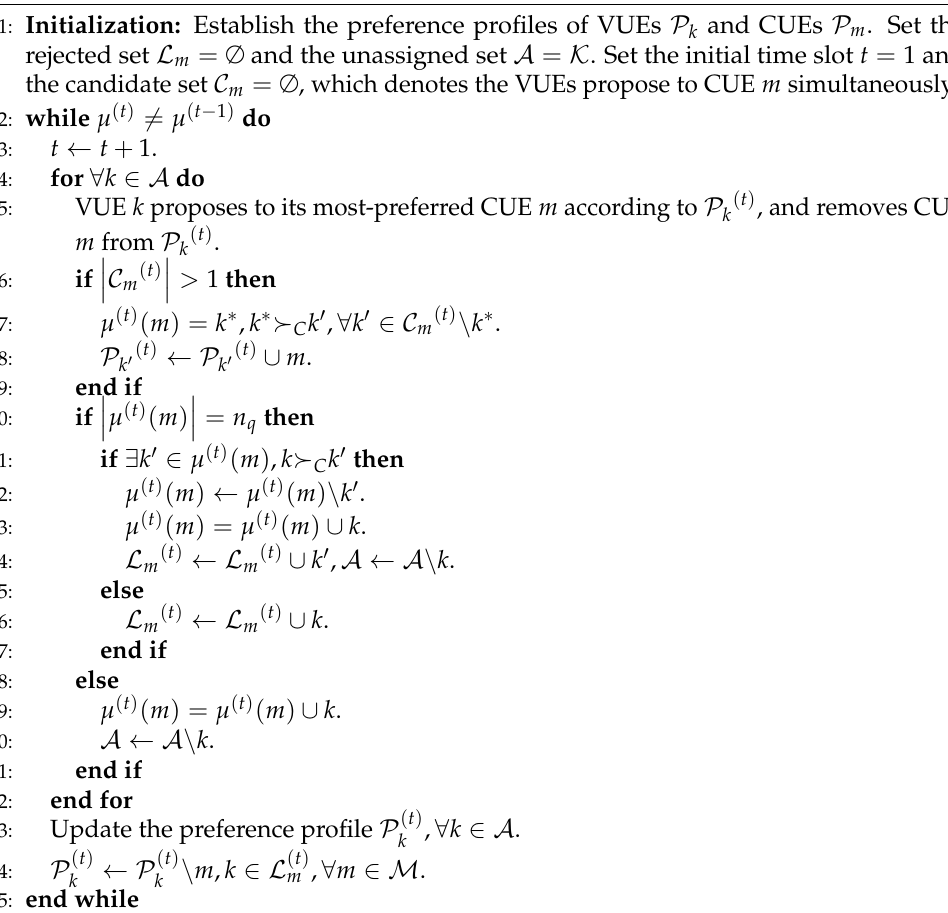
Algorithm 1 Spectrum Resource Allocation